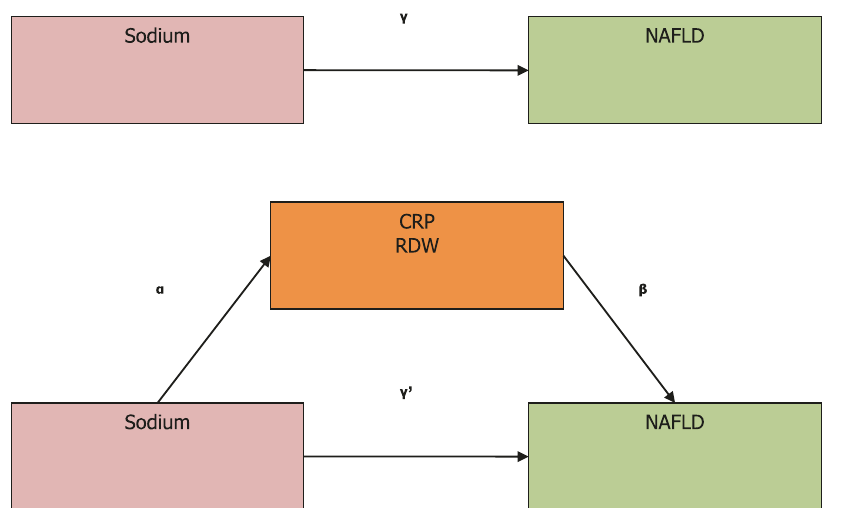
Fig. 2 Mediation model for the associations of dietary sodium intake with no-alcoholic fatty liver disease (NAFLD) with C-reactive protein (CRP) and red cell distribution width (RDW) as the mediators. Note: Path α represents the regression coef fi cient for the association of dietary sodium intake with CRP or RDW. Path β represents the regression coef fi cient for the association of CRP or RDW with NAFLD. The product of regression coef fi cients α and β represents the mediated effect (indirect effect) of CRP or RDW ( α * β ). Path γ ’ represents the direct effect of dietary sodium intake with NAFLD, after adjustment for CRP or RDW. Path γ represents the simple total effect of dietary sodium intake on NAFLD, without adjustment for CRP and